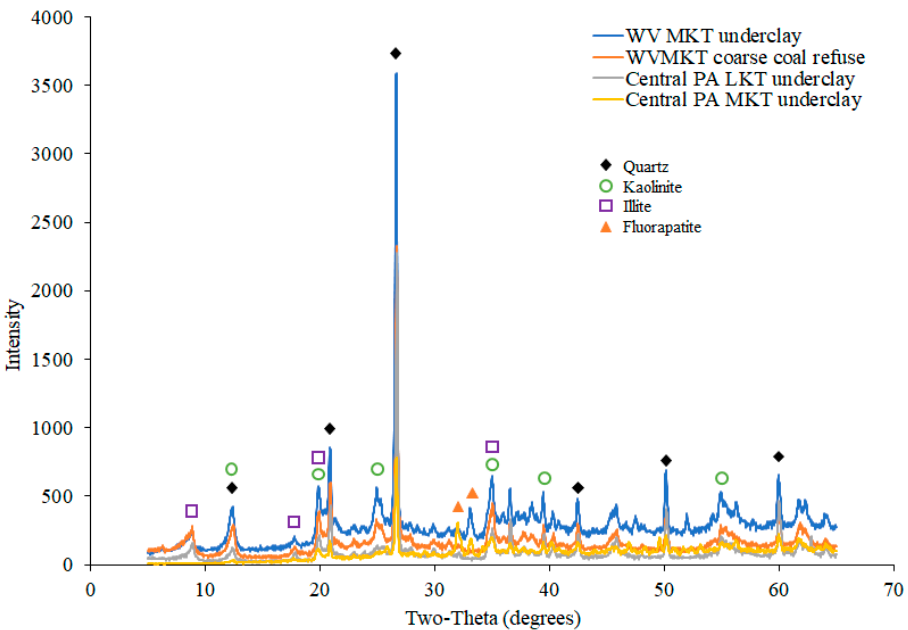
Figure 1. Semi-quantitative XRD data from the four coal-related samples.